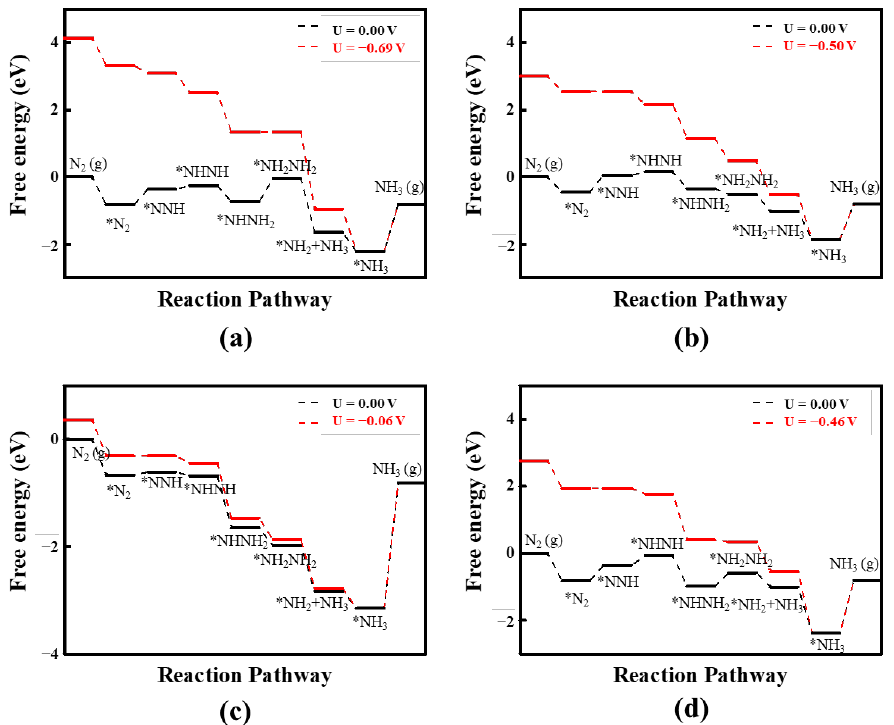
Figure 5. Free energy diagram of NRR on ( a ) Co 2 ⊥ vb-BN, ( b ) Rh 2 ⊥ vb-BN, ( c ) Pt 2 ⊥ vb-BN and ( d ) Rh 2 ⊥ vn-BN catalysts at zero and applied potentials (limiting potential) through the enzymatic mechanism.